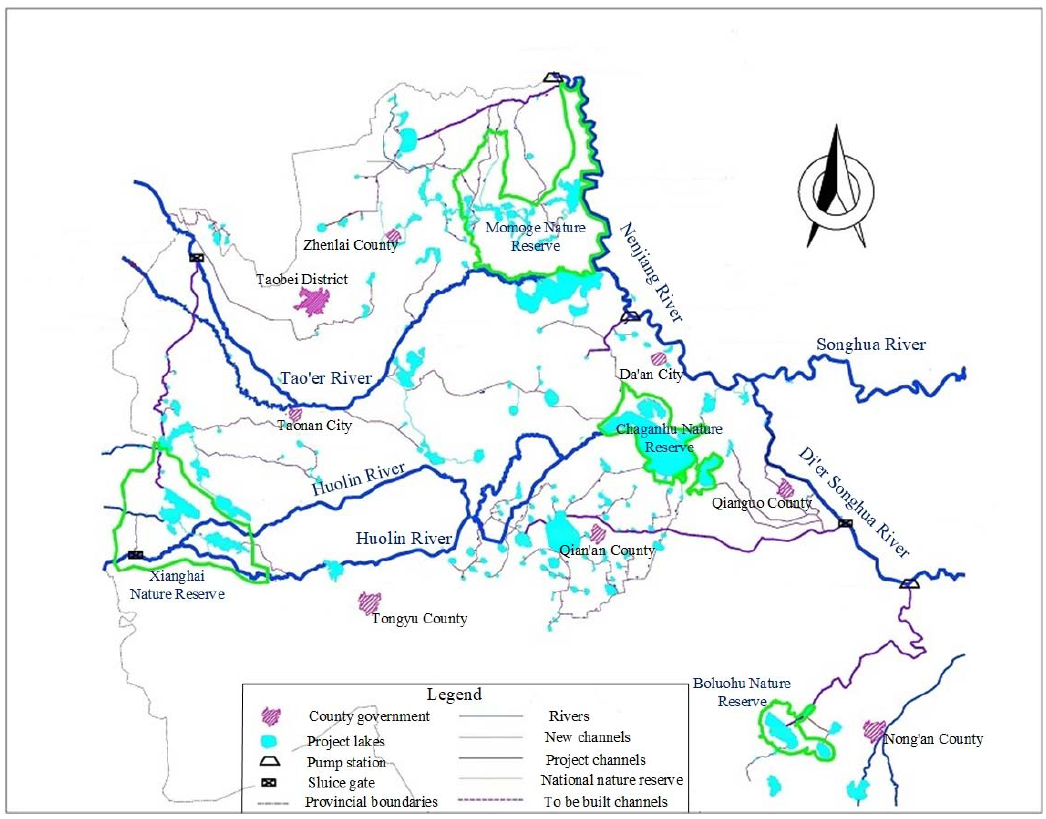
Figure 1. The geographical position of the interconnected river system network project in western Jilin Province.